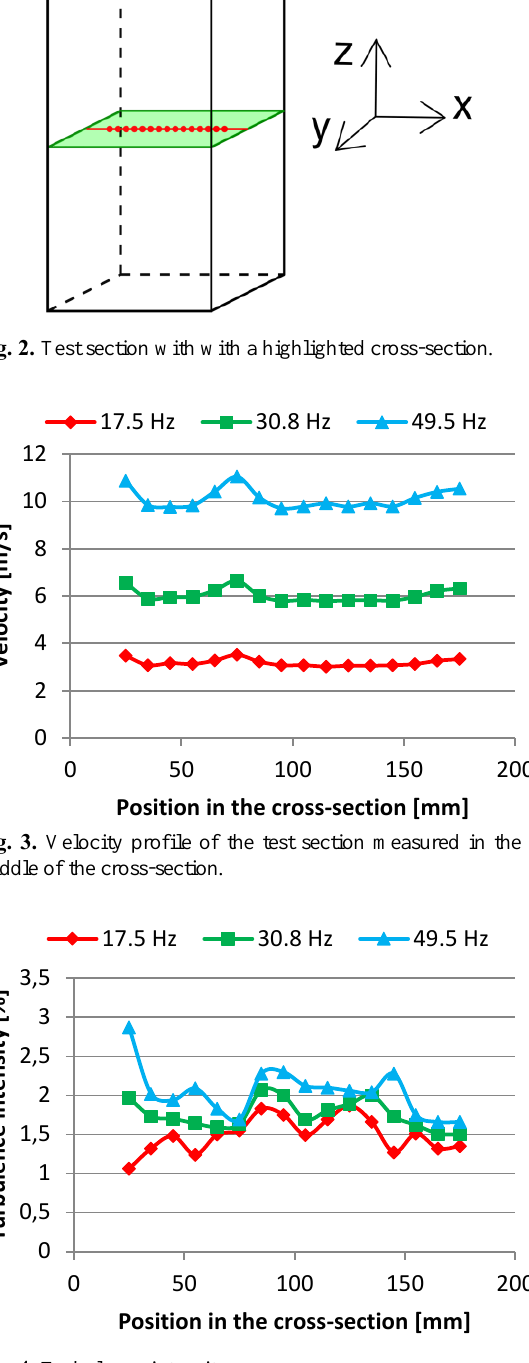
Fig. 4. Turbulence intensity